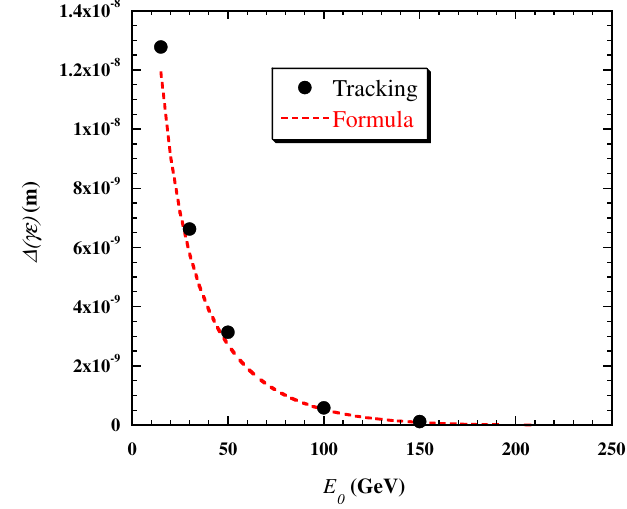
FIG. 5. Emittance growth induced by cavity tilt 15 (cid:10) rad (RMS) at the end of the linac (beam energy 250 GeV), as a function of initial beam energy. Results of tracking simulation (black circles) and the analytic formula (dashed line) for the ILC main